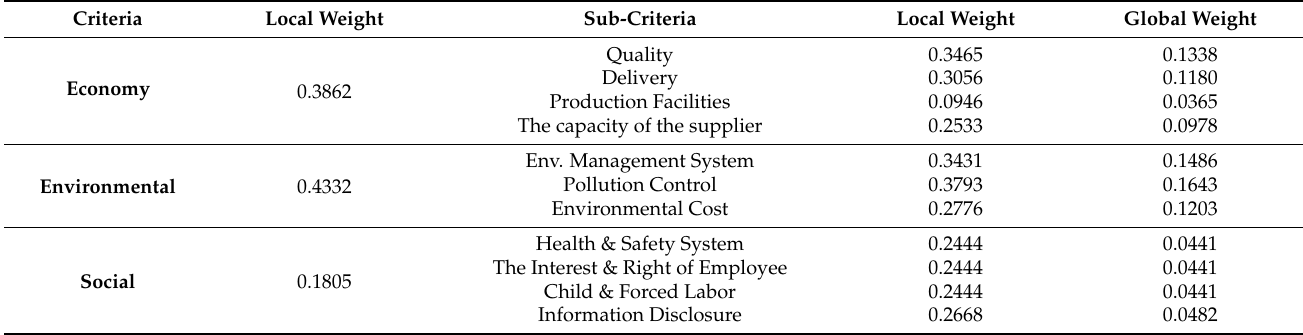
Table 4. The weight of the criteria and sub-criteria examined by experts.